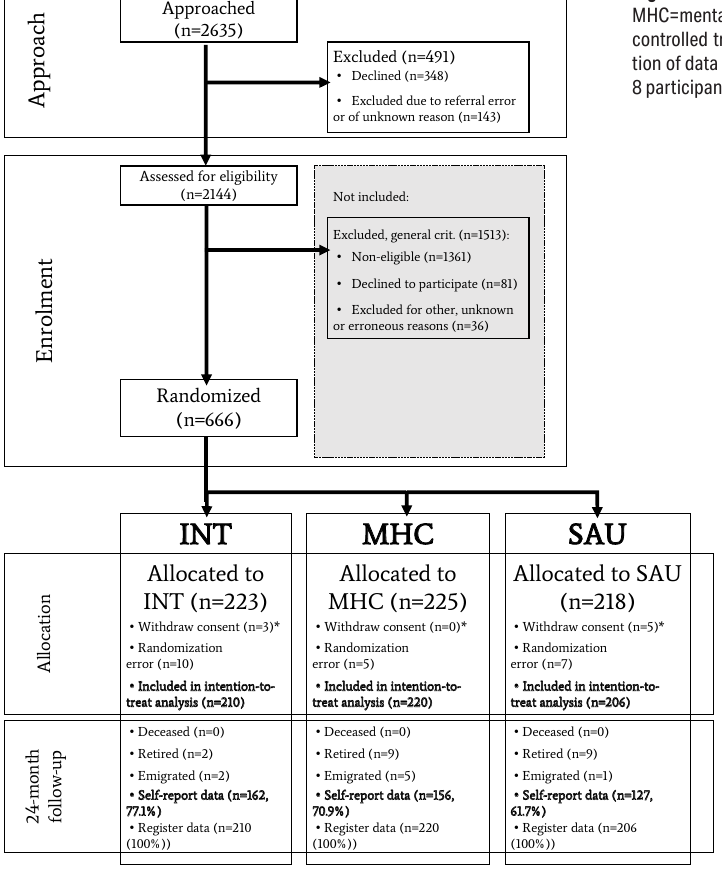
Figure 1. Participant flow. [INT=IBBIS integrated intervention; MHC=mental healthcare; SAU=service as usual; RCT=randomized controlled trial]. *Due to European data legislation, complete dele- tion of data was possible and was requested after randomization by 8 participants.